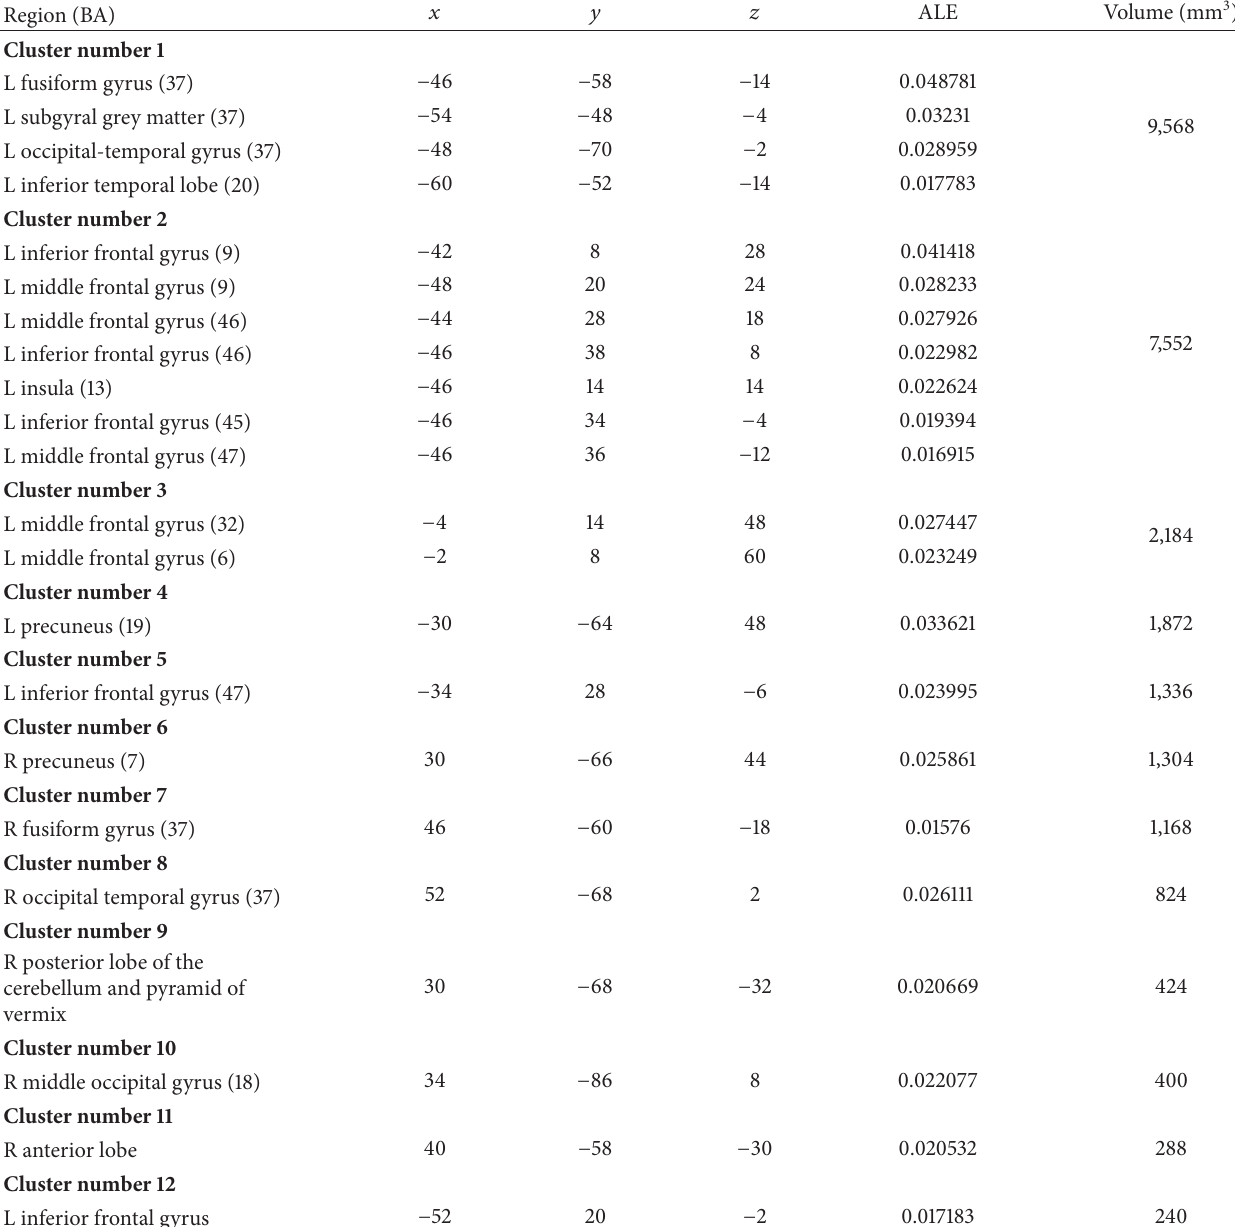
Table 3: Main loci of brain connectivity of BA37 in language tasks by meta-analytic connectivity modeling